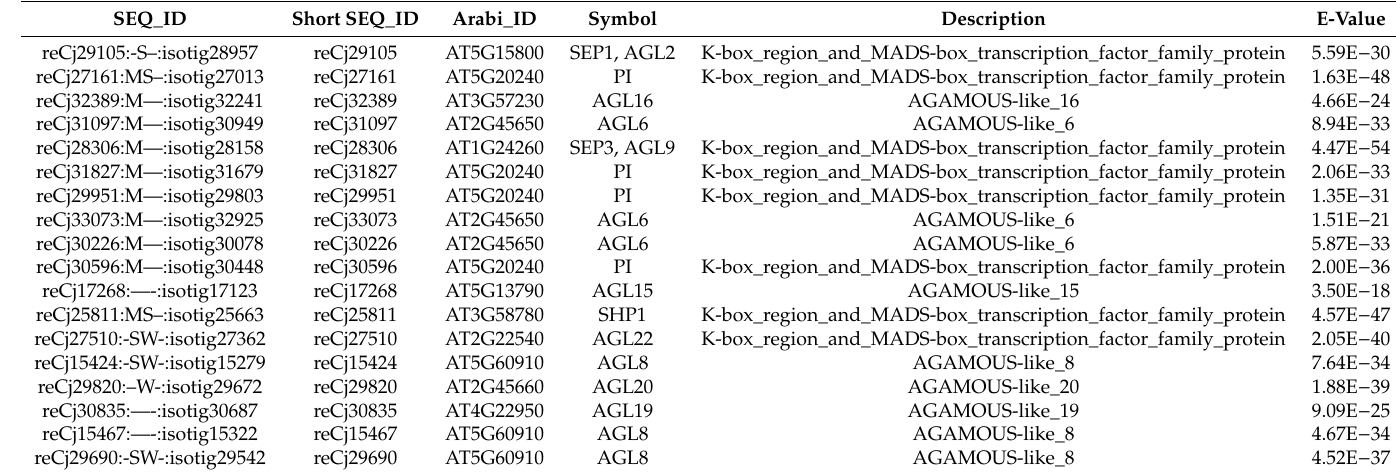
Table 2. The DEGs associated with MADS-box genes after GA 3